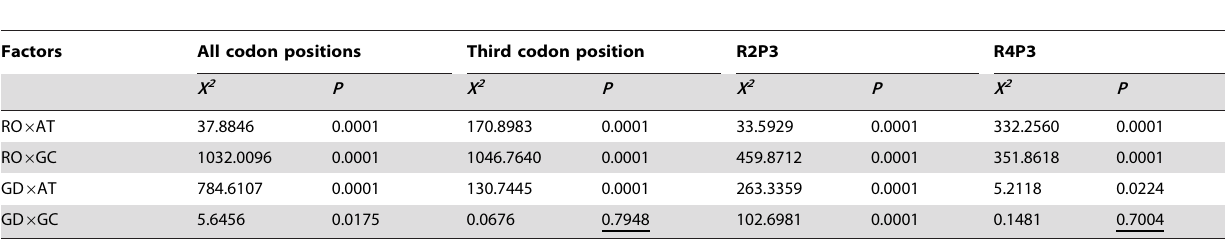
Table 1. Contingency table and chi-square test for gene direction/replication orientation and sign of skew value.